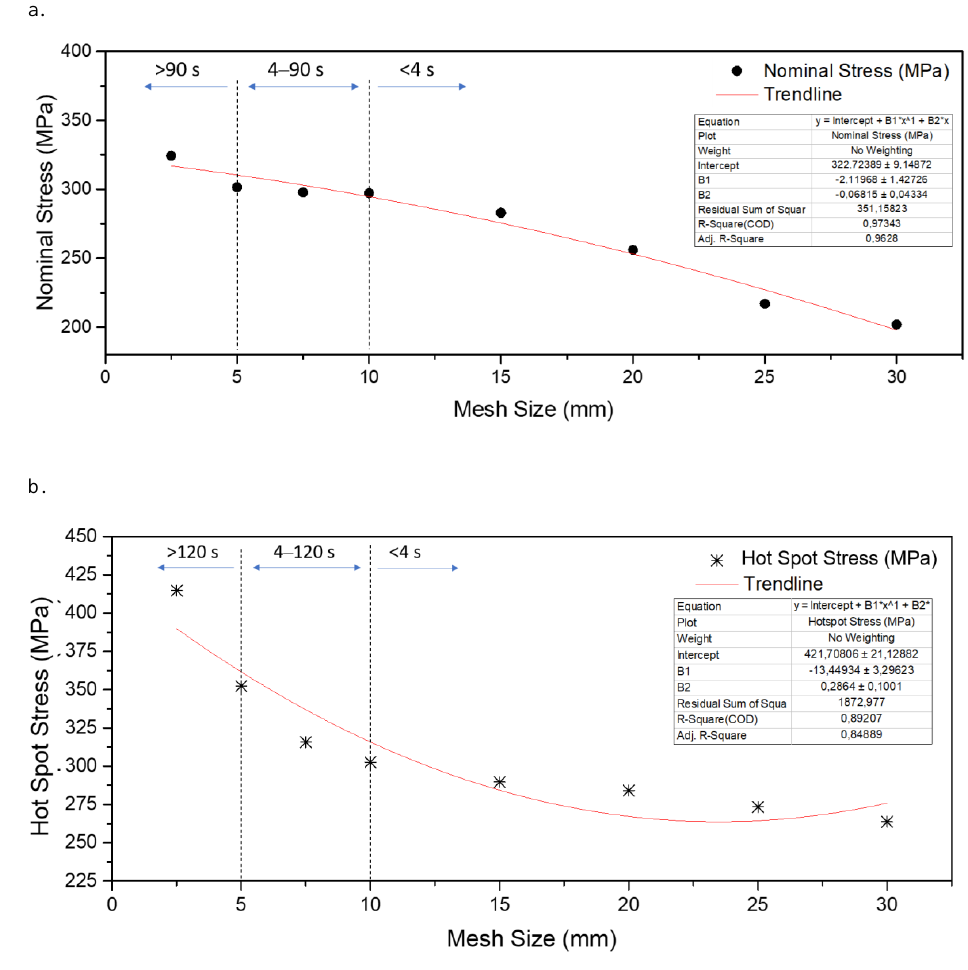
Figure 10. Mesh Convergence Tests: a. Nominal Stress; b. Hot Spot Stress Figure 10: Mesh convergence tests: a. Nominal stress; b. Hot spot stress a. b.